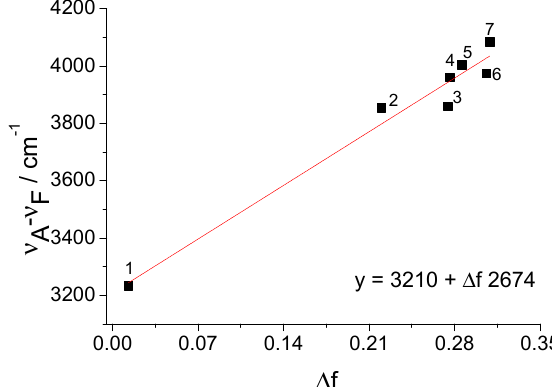
Figure 6. Dependence of the Stokes shift ( υ A − υ F ) on solvent polarity function ∆ f for NI3 in organic solvents: 1-toluene, 2-dichloromethane, 3-acetone, 4-DMF, 5-acetonitrile, 6-2-propanol, and 7-methanol.